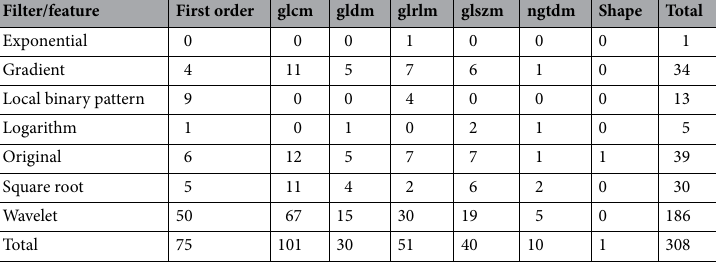
Table 4. Significant PyRadiomics features in univariate CPH across different types of filters and features.